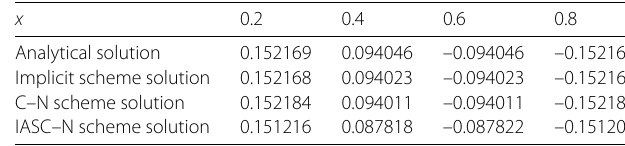
Table 1 Comparison of scheme solutions and analytical solutions ( α =